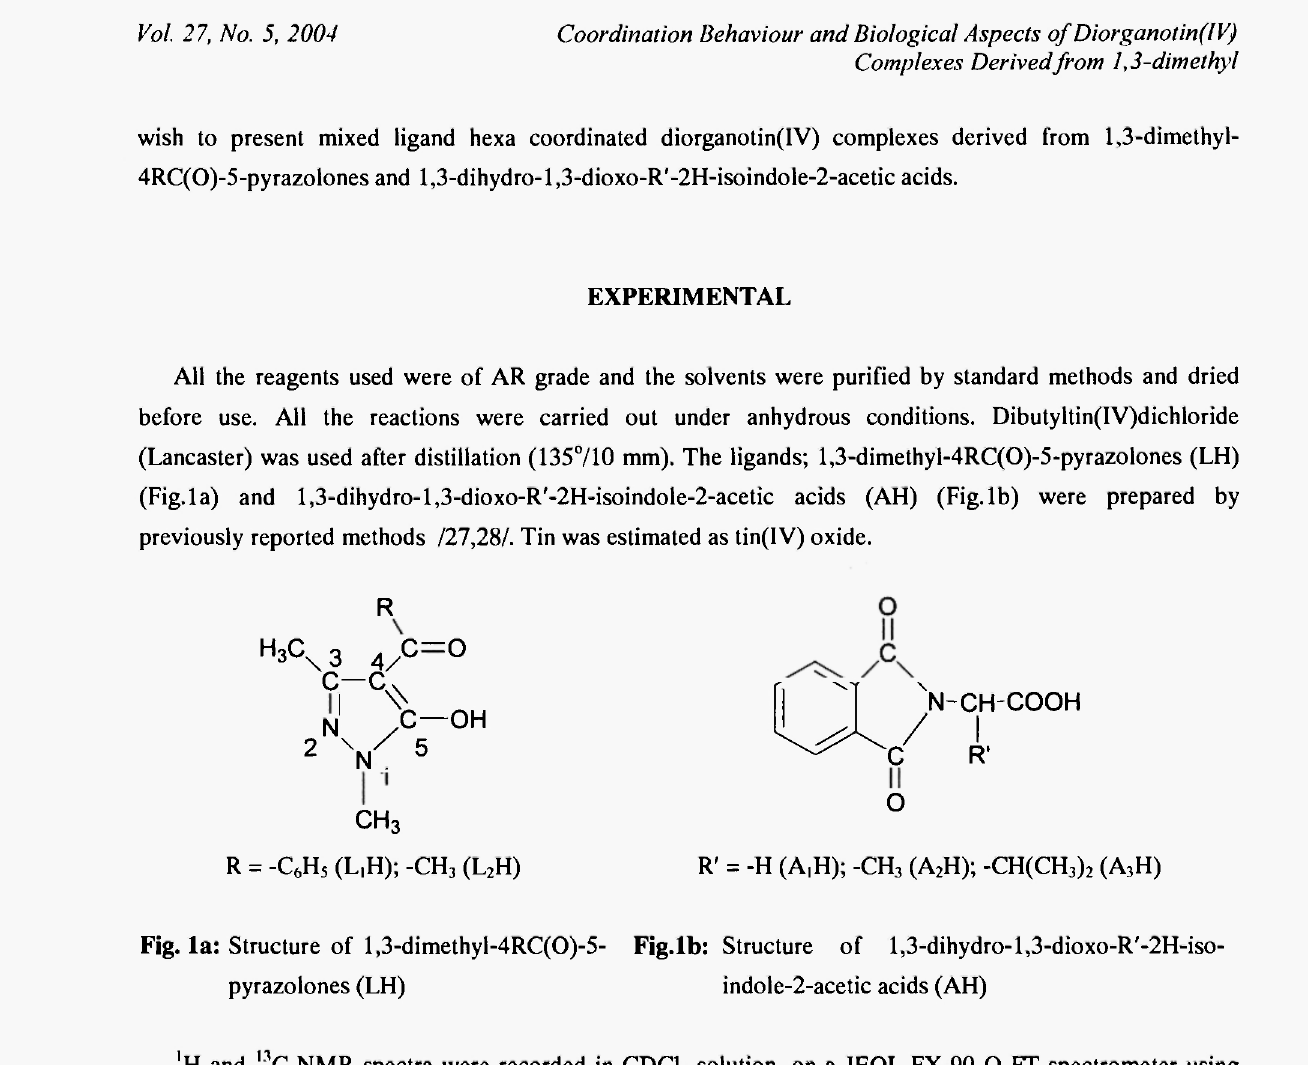
Fig. la: Structure of l,3-dimethyl-4RC(0)-5- Fig.lb: Structure of l,3-dihydro-l,3-dioxo-R'-2H-iso- pyrazolones (LH) indole-2-acetic acids